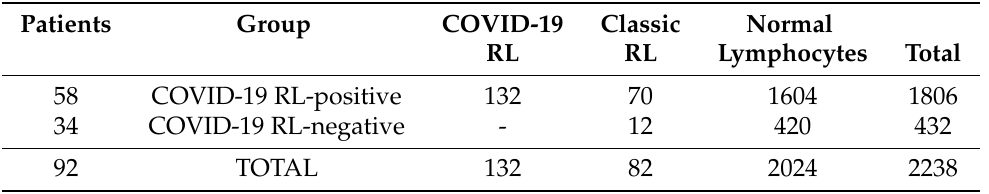
Table 5. Image dataset used for the experimental assessment. Number of images of the three classes of cells under study: COVID-19 RL, classic RL, and normal lymphocytes.